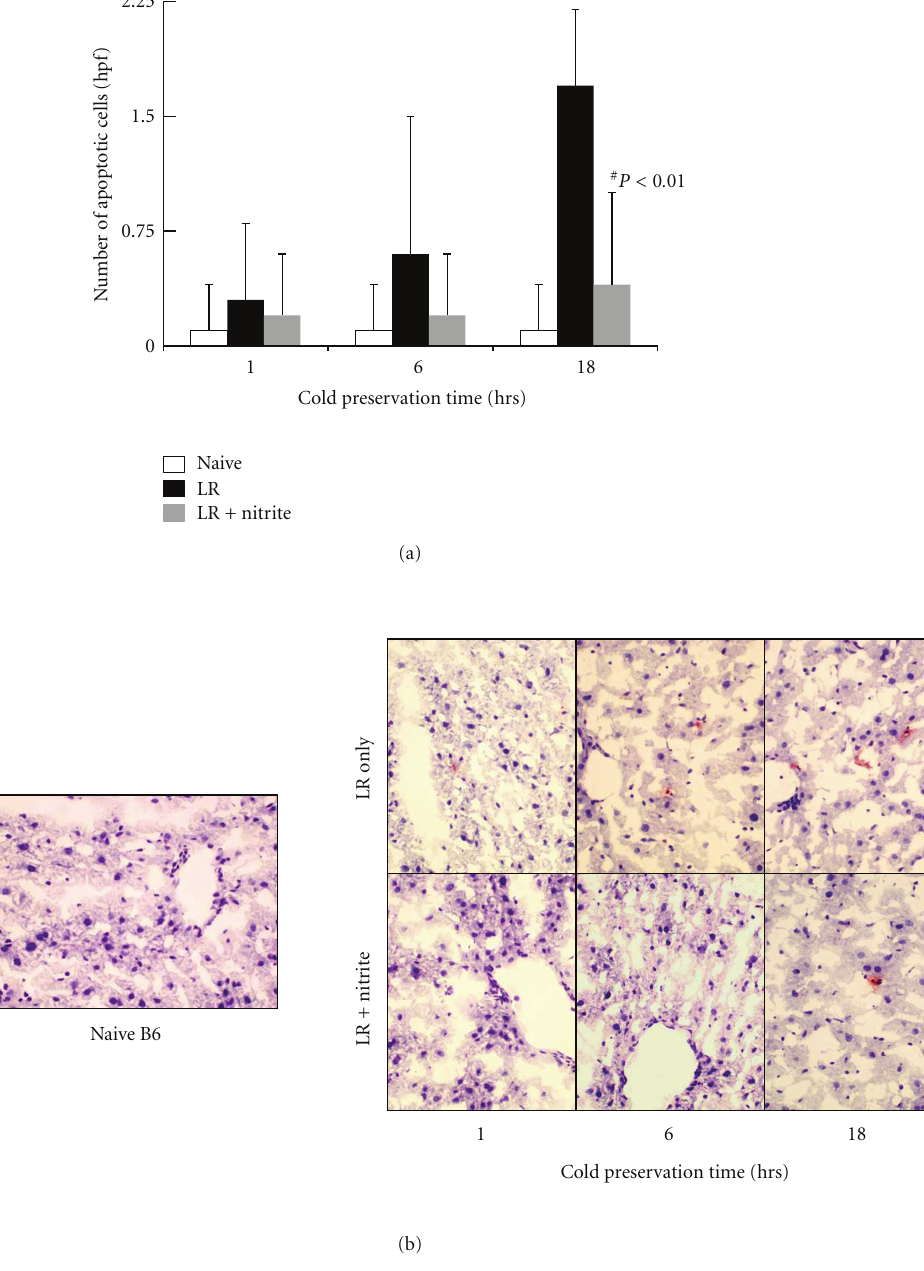
Figure 5: Hepatocellular apoptosis significantly decreased within LR-supplemented nitrite therapy. TUNEL evaluation revealed a significantly reduced number of hepatocellular apoptotic nuclei treated with nitrite at 18 hours (0 . 1 ± 0 . 3 versus 1 . 7 ± 0 . 4 versus 0 . 4 ± 0 . 5). Data are expressed as mean ± SE. # P < 0 . 05 for corresponding